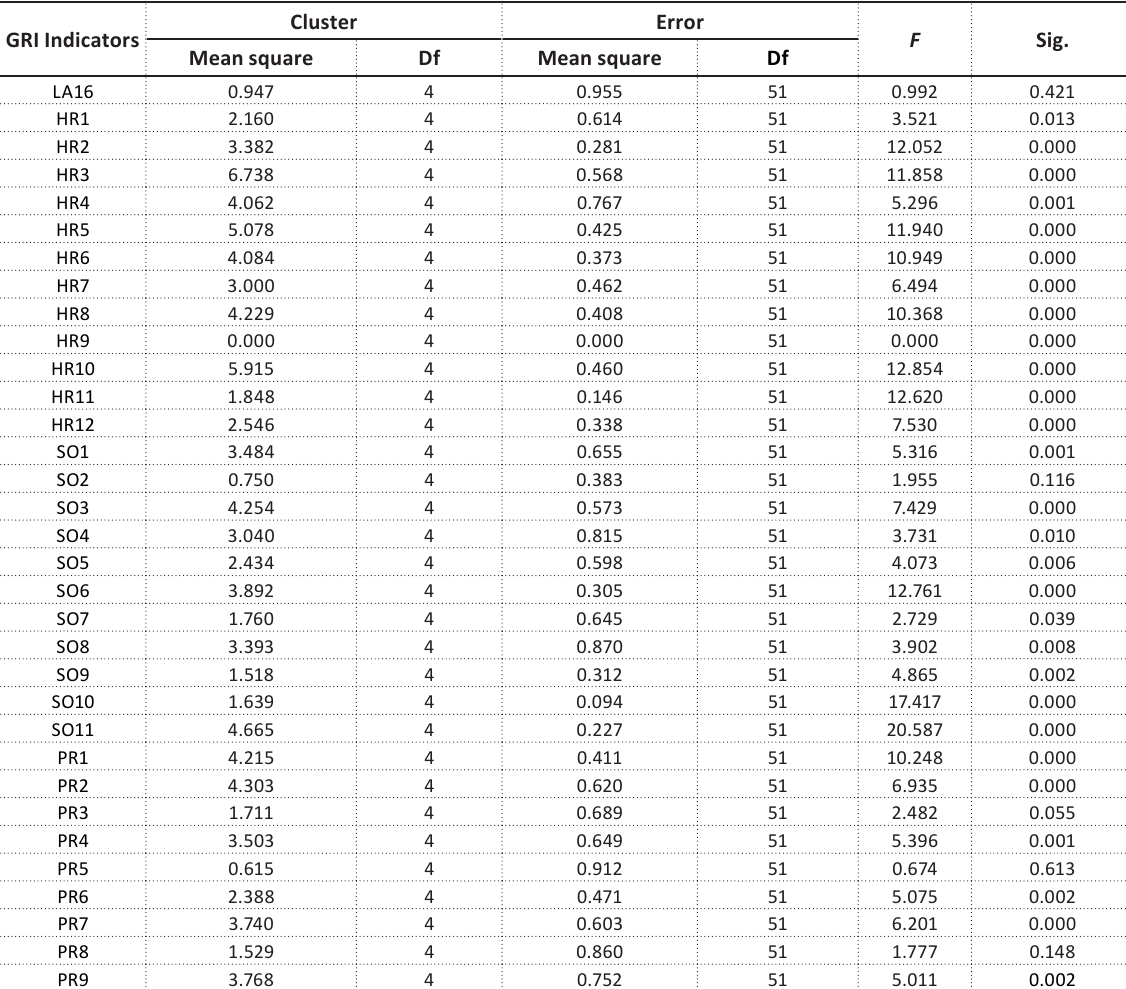
Table 2 (cont.). ANOVA/ F -test